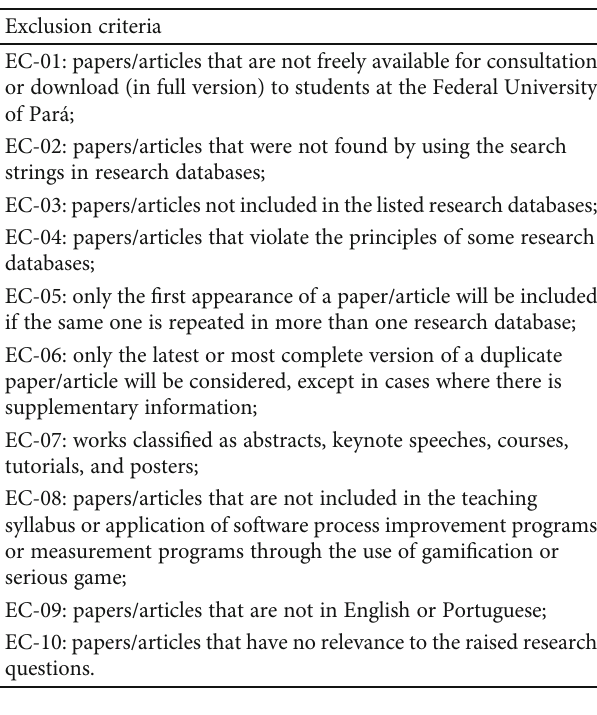
Table 3: Exclusion